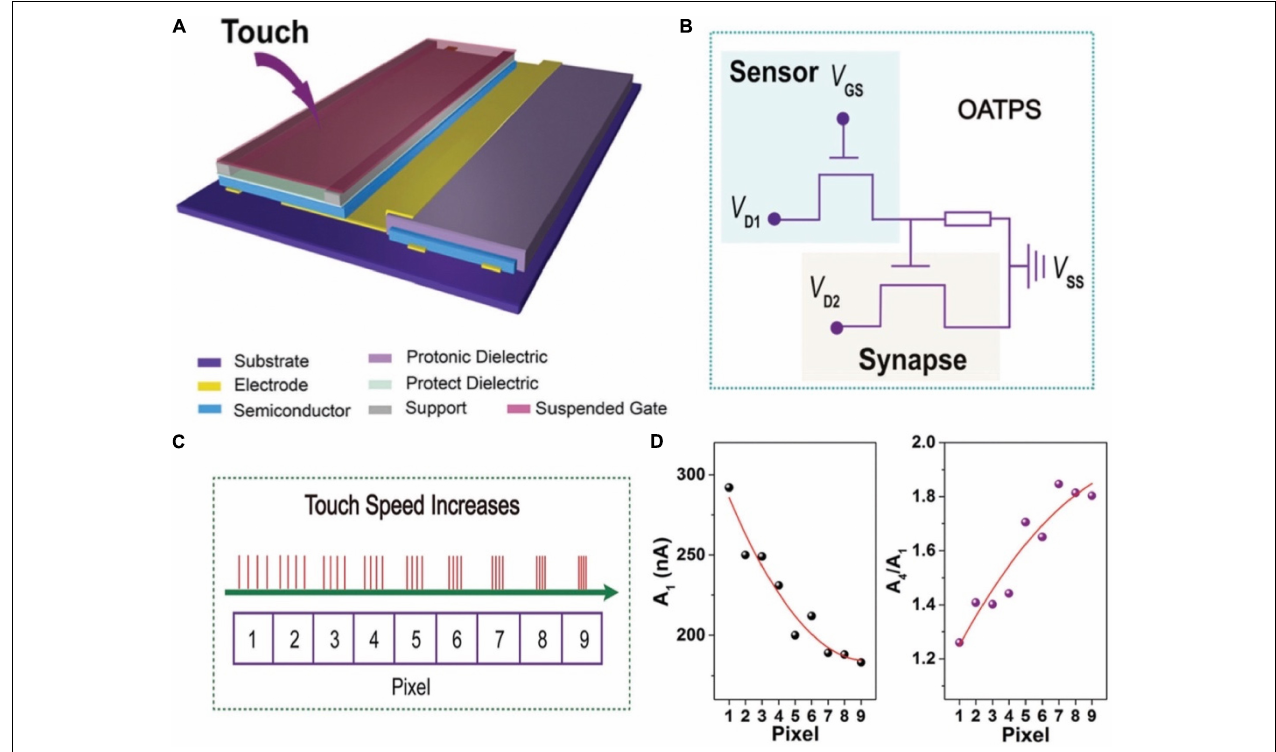
FIGURE 16 | (A) Schematic illustration of the DOT-TPS. (B) Equivalent electrical circuit of the DOT-TPS. (C) Four continuous and repeated touch cycles applied to the nine pixel. (D) The EPSC (A 1 ) and the gain A 4 /A 1 for each pixel (adapted from Zang et al., 2017).